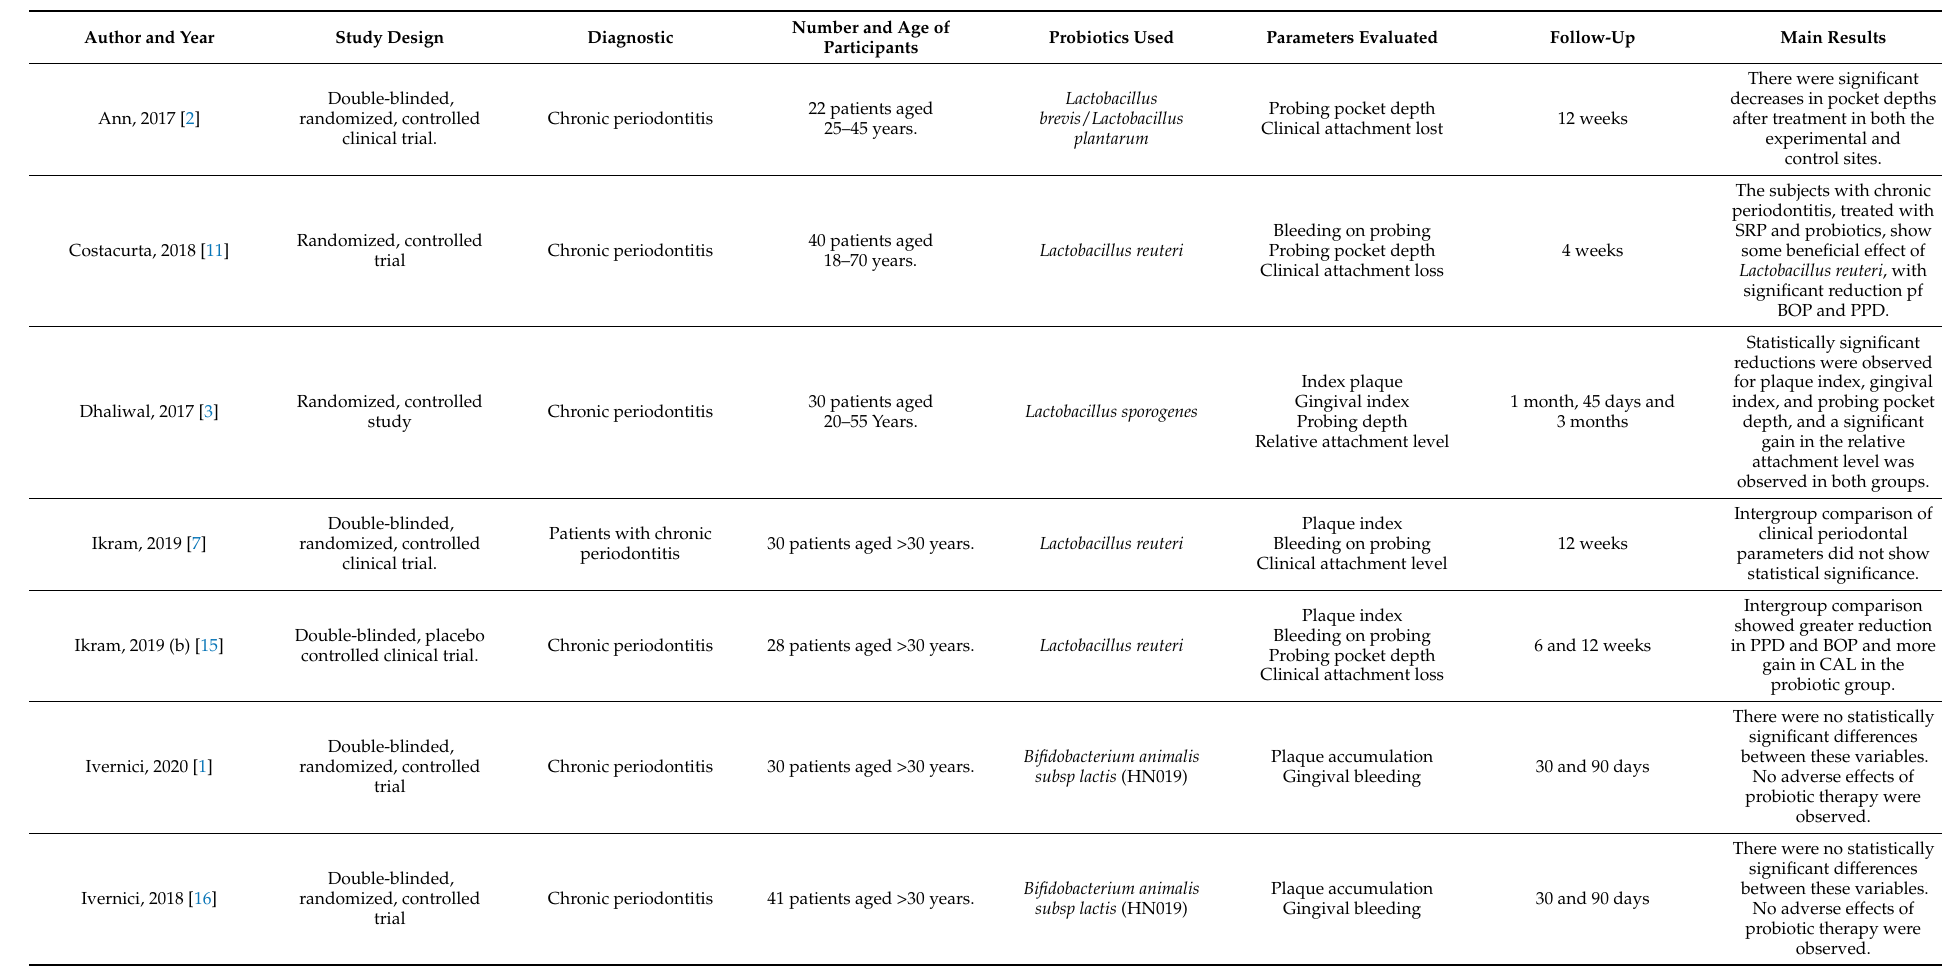
Table 2. Qualitative analysis of the included